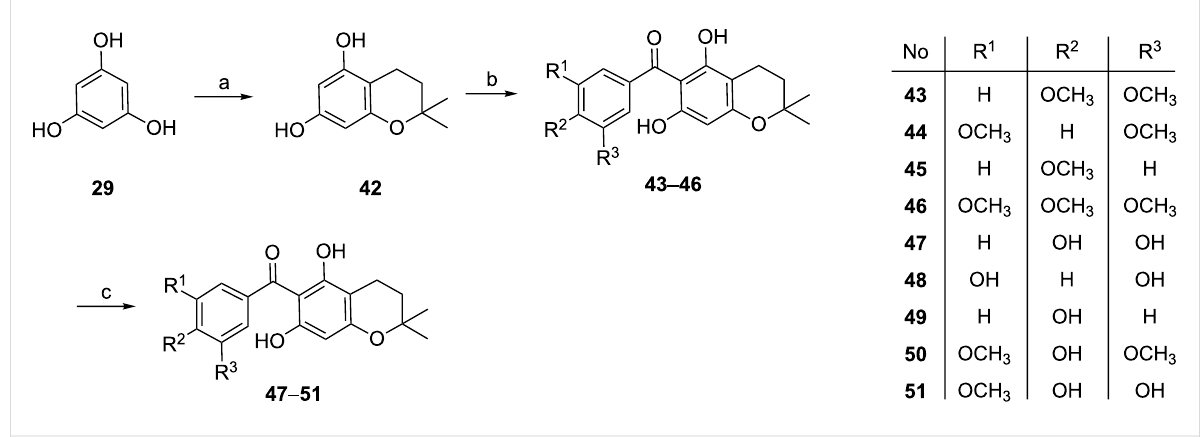
Scheme 8: Synthesis of acylphloroglucinol derivatives 43–51 . Reagents and conditions: ( a ) isoprene, Amberlyst 15, THF/hexane; ( b ) benzoyl chlo- ride,